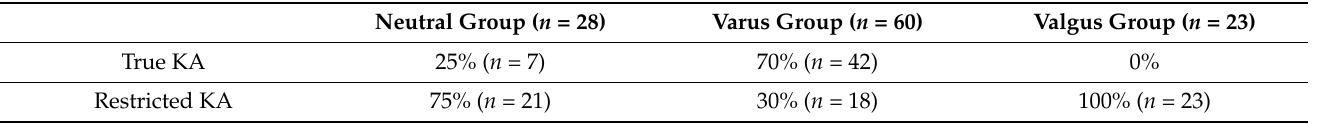
Table 3. Distribution of alignment philosophy chosen for each subgroup.